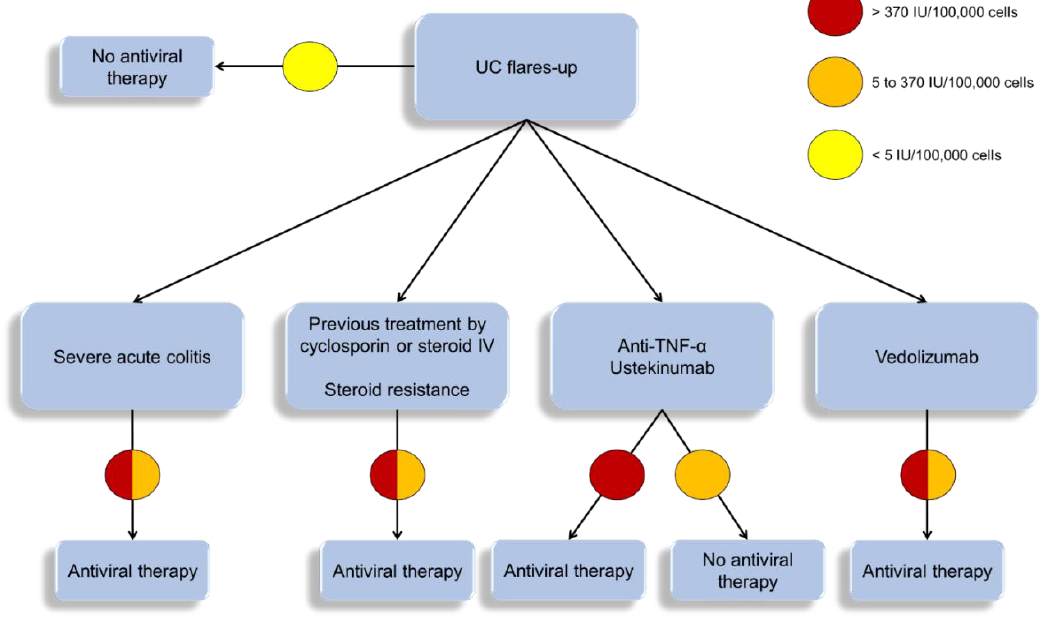
Figure 3. Therapeutic algorithm for the intake of flare-ups of ulcerative colitis (UC), according Table 1. The algorithm is drawn according to the last recommendations [8,68,158] and publications